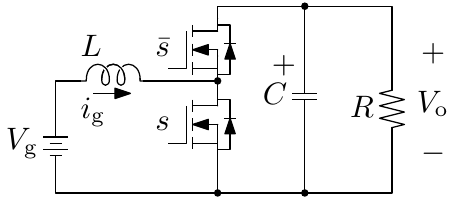
Figure 1. Conventional boost power converter.